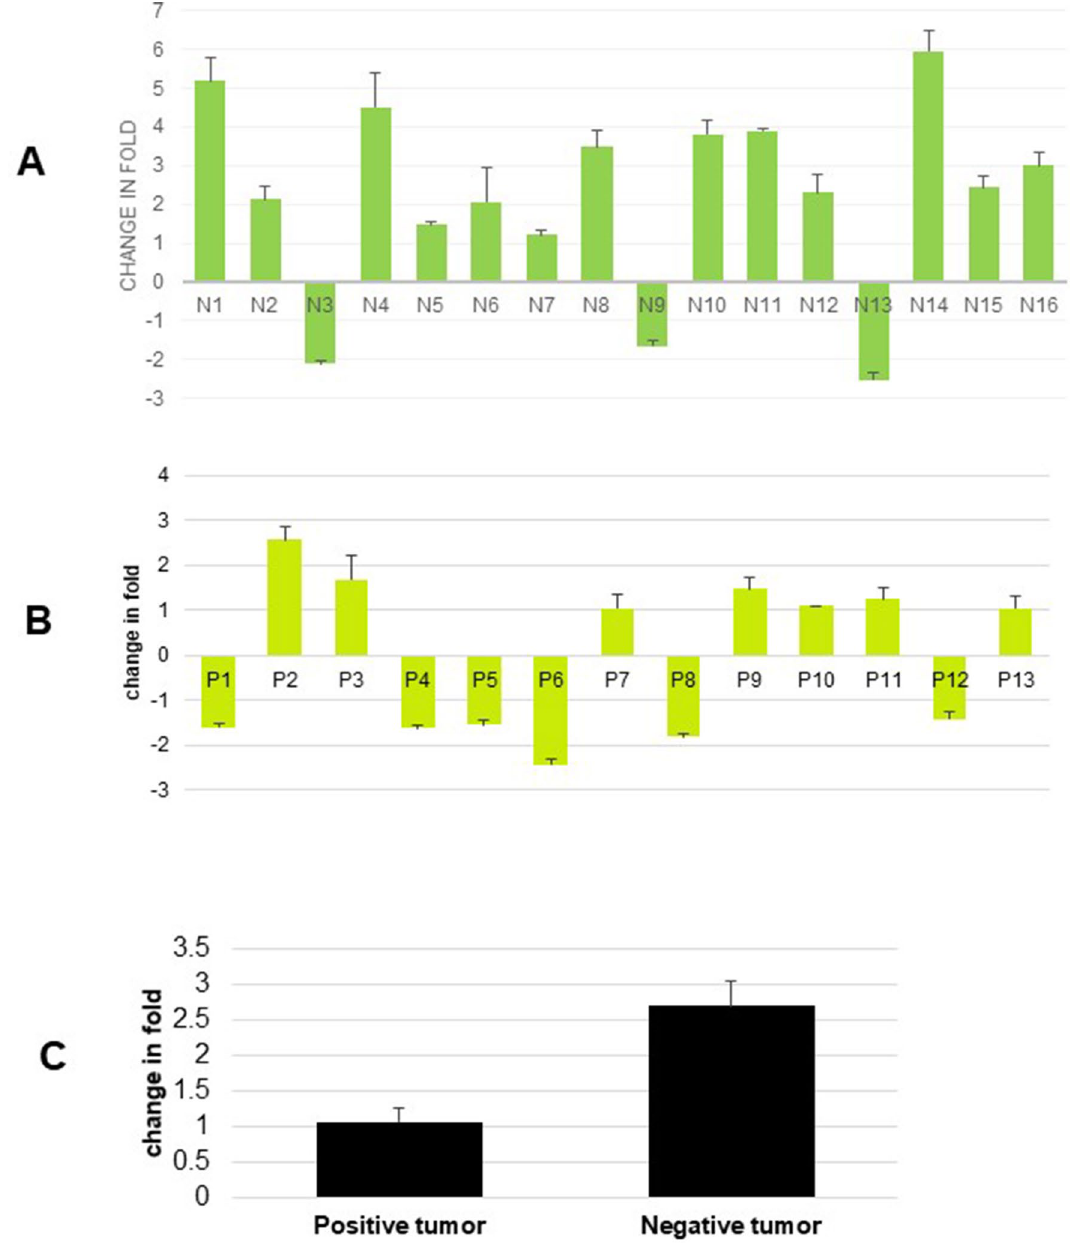
Figure 4. TaqMan real time PCR analysis of miRNA-200C expression in the FANCD2 foci defective and foci positive lung tumor tissues. TaqMan real time PCR was employed for analyzing miRNA-200C in FANCD2 foci positive and foci negative tumor samples. Out of the 16 FANCD2 foci negative tumors, the miRNA-200C was increased in 13 (81%) cases as compared to matched non-tumor lung tissue ( A ). Comparably, among 13 FANCD2 foci positive tumor samples, miRNA-200C was increased in 7(54%) cases ( B ). The average of fold change on miRNA-200C in the foci negative samples was 2.7 indicating overexpression in the foci negative tumors compared to matched non-tumor lung tissue. Comparably the averaged fold change in 13 foci positive tumors was nearly 1 which indicates miRNA-200C expression does not vary significantly between tumor and non-tumor counterpart for FANCD2 foci positive tumors ( C